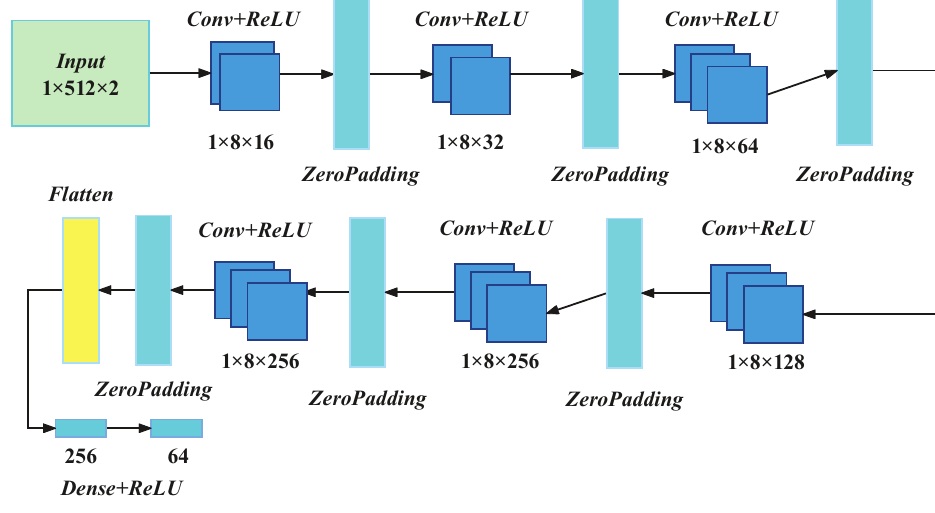
Figure 3. The architecture of the discriminator